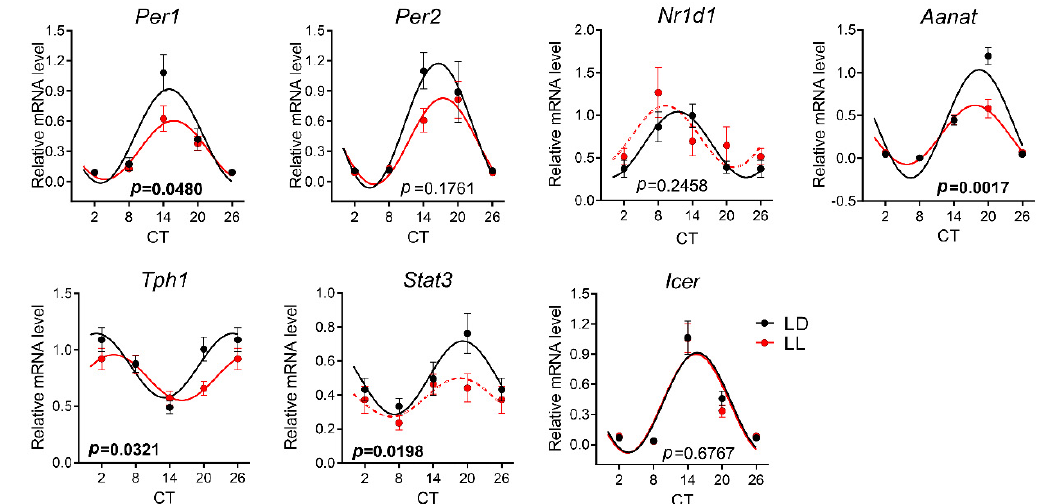
Figure 7. The e ff ect of development under constant light (LL in red, controls on LD in black) on rhythmic gene expression in the pineal gland at P90. The animals were housed under LL (16 lux) from P0 until P20 and then released into LD conditions. At P90, the animals were sacrificed in 6 h intervals in DD, and pineal glands were processed by qPCR with specific TaqMan probes. The rhythmicity was proved by cosinor analysis with the horizontal line as a zero hypothesis and one-way ANOVA for the di ff erence between time groups. Full lines indicate the rhythms that were confirmed by cosinor analysis and one-way ANOVA. The dashed lines indicate the profiles that were not confirmed for rhythmicity by one or both methods. Each point represents the mean ± SEM from five to seven animals. p -values indicate group di ff erence by two-way ANOVA, and significant values are in bold.